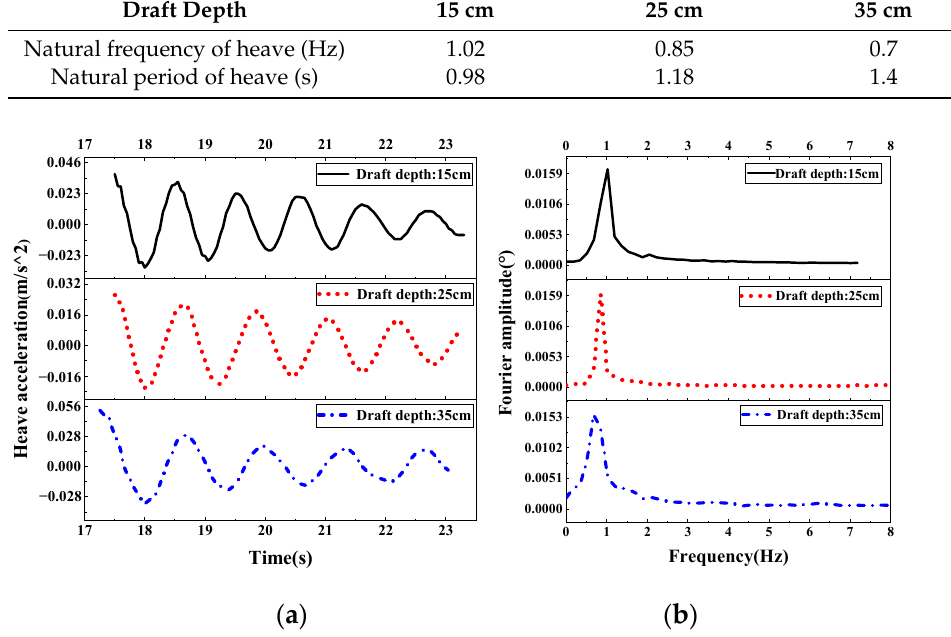
Figure 9. Natural period for the heave of different drafts. ( a ) Acceleration of heave variation. ( b ) Spectrum diagram of heave variation. Table 4. The natural period of heave for different drafts.